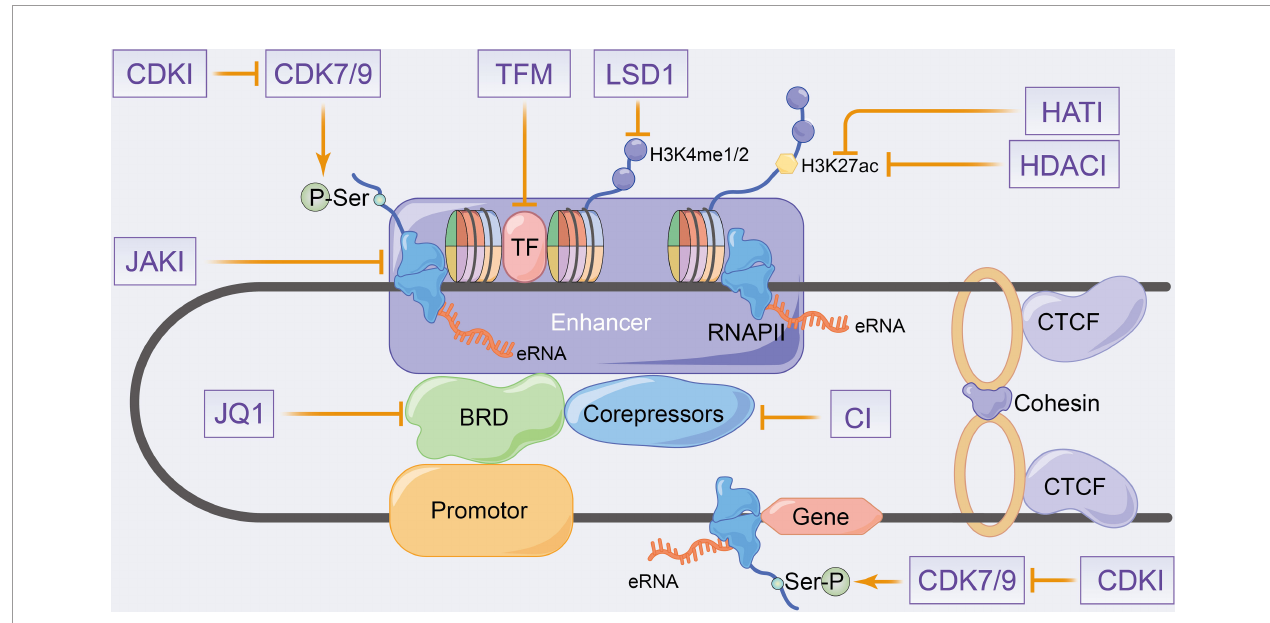
FIGURE 4 | Schematic representation of putative therapeutic targets to enhancer transcription events and eRNA landscapes. CDKI, cyclin-dependent kinase inhibitors; HATI, histone acetyltransferase inhibitors; HDACI, histone deacetylase inhibitors; LSD1, lysine-speci fi c demethylase 1; JAKI, janus kinase inhibitors; TFM, transcription factors inhibitors; CI, co-repressors